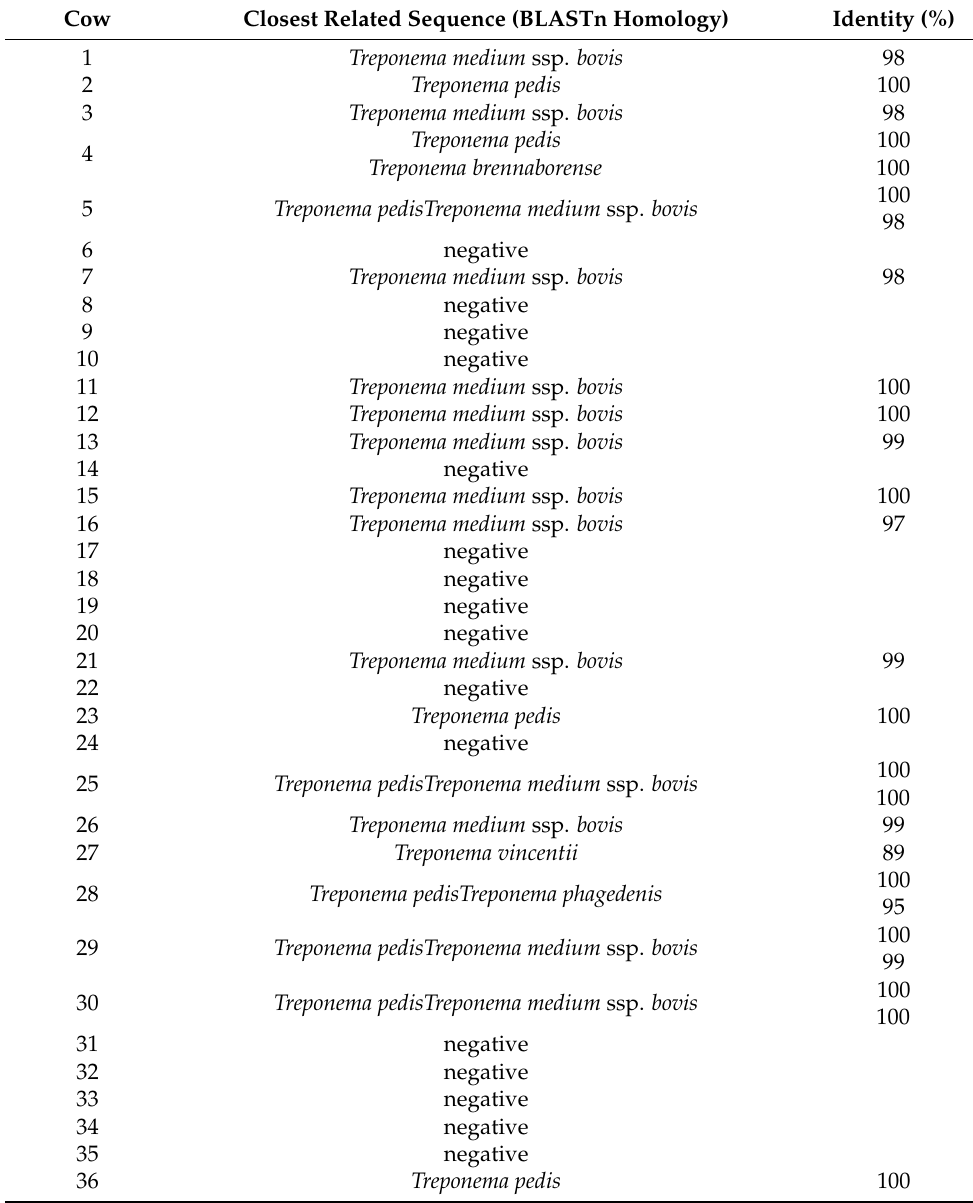
Table 5. Treponema spp. detection of samples from BDD